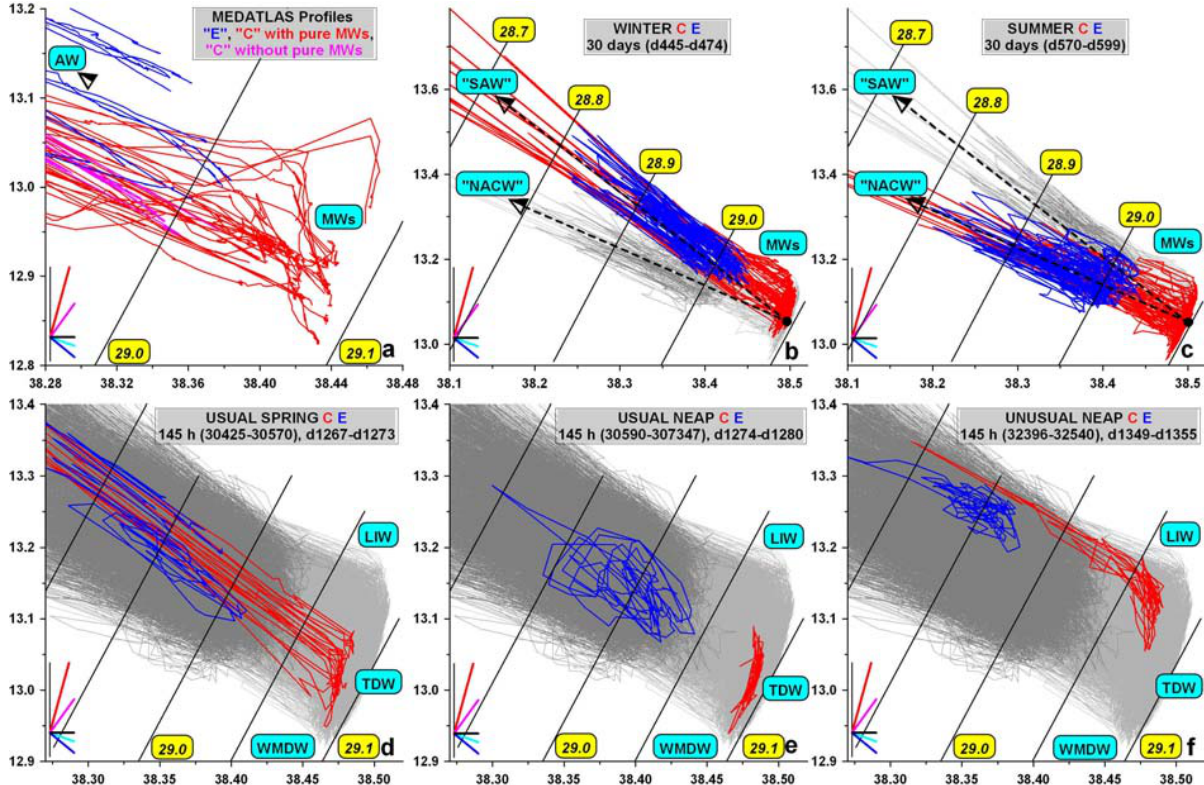
Fig. 4. 2 - S diagrams plotted with axes lengths allowing computed slopes A (in ◦ ) to be compared to those of the segments coloured in red (+75 ◦ , 12 / 1S ∼ 7 . 5 ◦ C), magenta (+55 ◦ , 2.9 ◦ C), cyan ( − 20 ◦ , ∼ − 0.7 ◦ C) and blue ( − 40 ◦ , ∼ − 1.7 ◦ C) and plotted with respect to the black segment. In all figures, mixing lines at C (E) are in red (blue). (a) Diagrams from CTD profiles in the vicinity of C and E, i.e. in rectangular areas centred on the moorings locations (latitude and longitude ± 1 0 at C and ± 5 0 at E); at C, some diagrams (magenta) do not contain evidence of any pure MWs. ( b and c ) Diagrams for the winter and summer/spring periods defined in cyan and magenta in Fig. 3a together with the corresponding mixing lines between the same MW (black dot) and some kinds of NACW and SAW; diagrams for the other season are plotted in light (C) or dark (E) grey. ( d , e and f ) Diagrams for the usual spring, usual neap and unusual neap periods defined in cyan, magenta and green in Fig. 3c; diagrams for the whole time series are plotted in light (C) or dark (E)